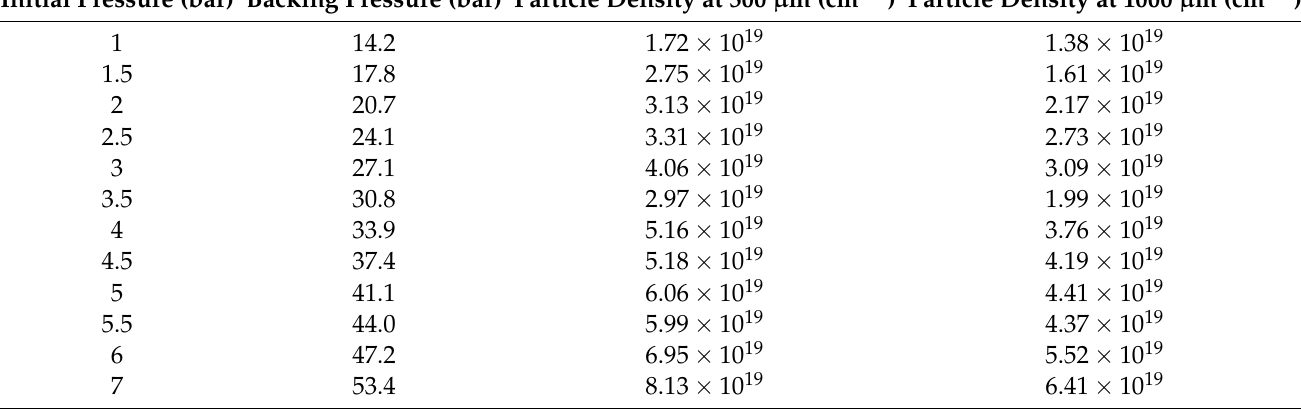
Table 1. Achievable gas densities at 500 µ m and 1000 µ m above the nozzle for various values of the input and backing pressures in the compressor [37].